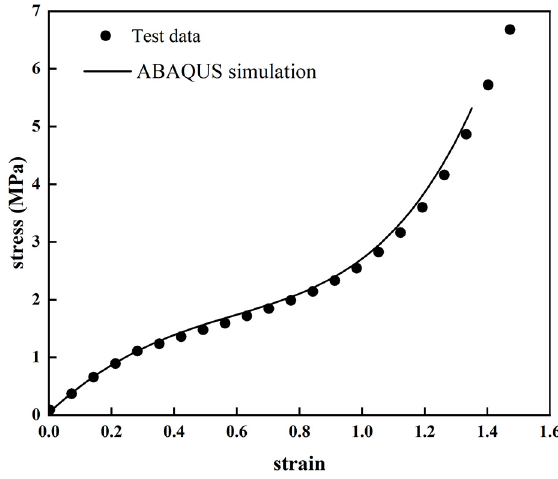
Figure 11. The stress–strain curve of the FEA results and the experimental data of the C60 rubber specimen.